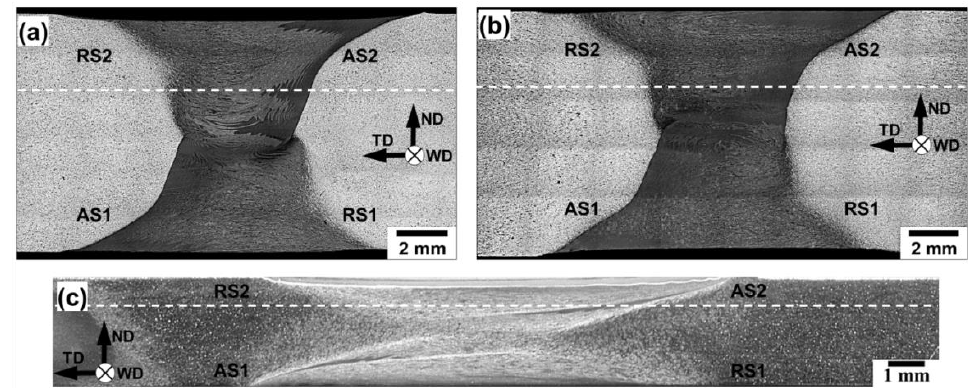
Figure 1. Optical macrographs of the weld cross-sections: ( a ) Al-Mg-Sc alloy in the initial cast condition, ( b ) Al-Mg-Sc alloy in the initial hot-rolled condition, and ( c ) 6061 aluminum alloy. WD, ND, and TD are welding direction, normal direction, and transverse direction, respectively. AS and RS are advancing side and retreating side, respectively; digits indicate a number of friction-stir welding (FSW) pass. Dotted lines show microhardness profiles.